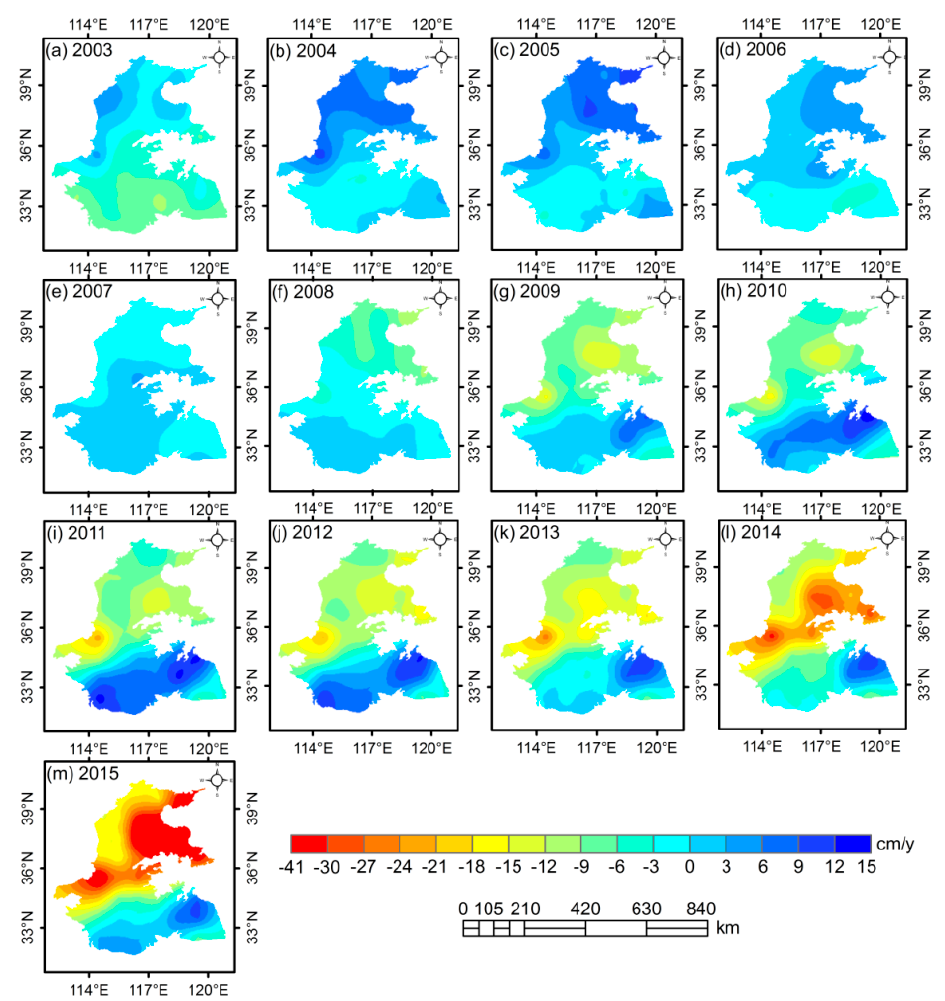
Figure 5. Spatial distribution of GWSA based on GRACE in the 3H Plain from 2003 to 2015.